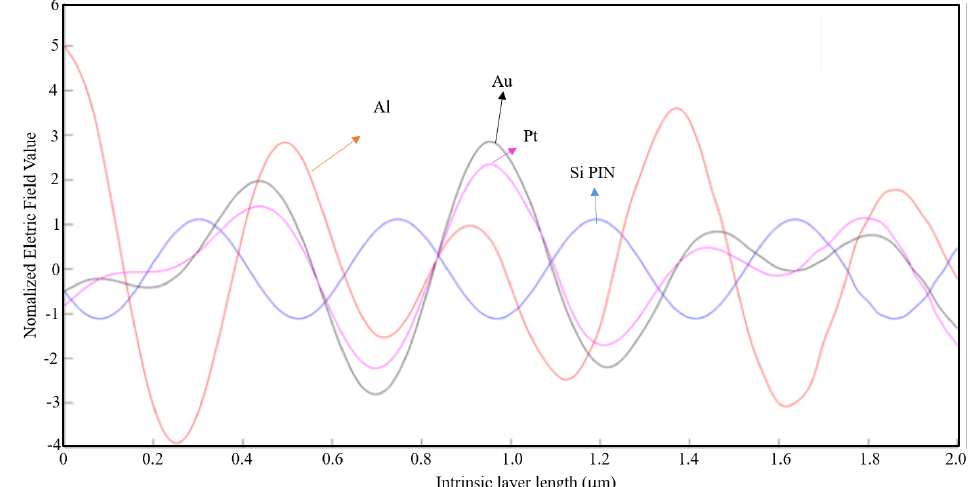
Figure 21. 1D Plot of the normalized electric field, z-component, along the intrinsic zone for different nanoantenna material types: Si PIN junction (blue), Al nanoantenna (red), Au nanoantenna (black), and Pt nanoantenna (magenta) (15-slit array; light wavelength: 1550 nm; metal thickness: λ /100; air slit width: λ